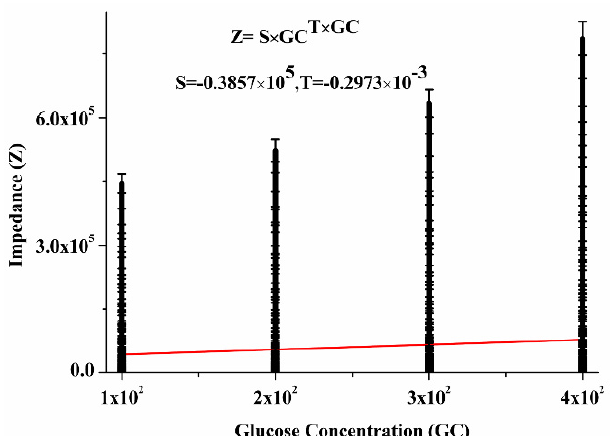
Fig. 9: Dependence plot of impedance with respect to glucose